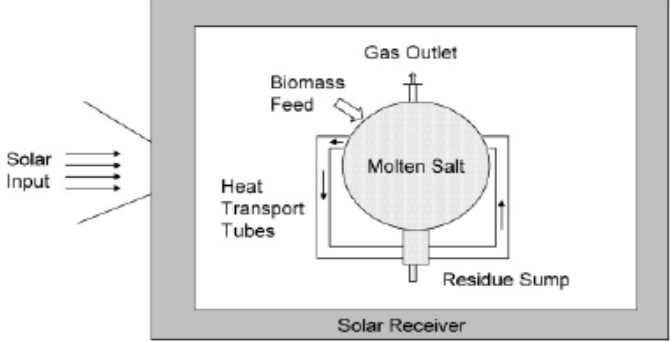
Figure 6. Concept of the reactor for solar gasification (Figure adapted from Adinberg et al. [179]. Reproduced from reference [77] by permission of the Royal Society of